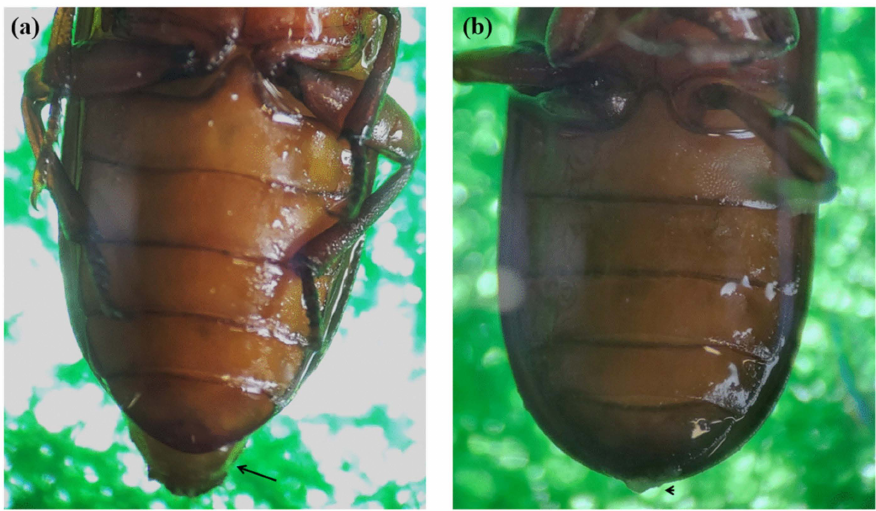
Figure 2. Distinguishing between female and male adult mealworms. Sexual difference of female adult brown mealworms is determined by the presence or absence of a protrusion on the fifth segment of the abdomen. Females (( a ); arrow) have a sharper protrusion than males (( b ); arrow-head).